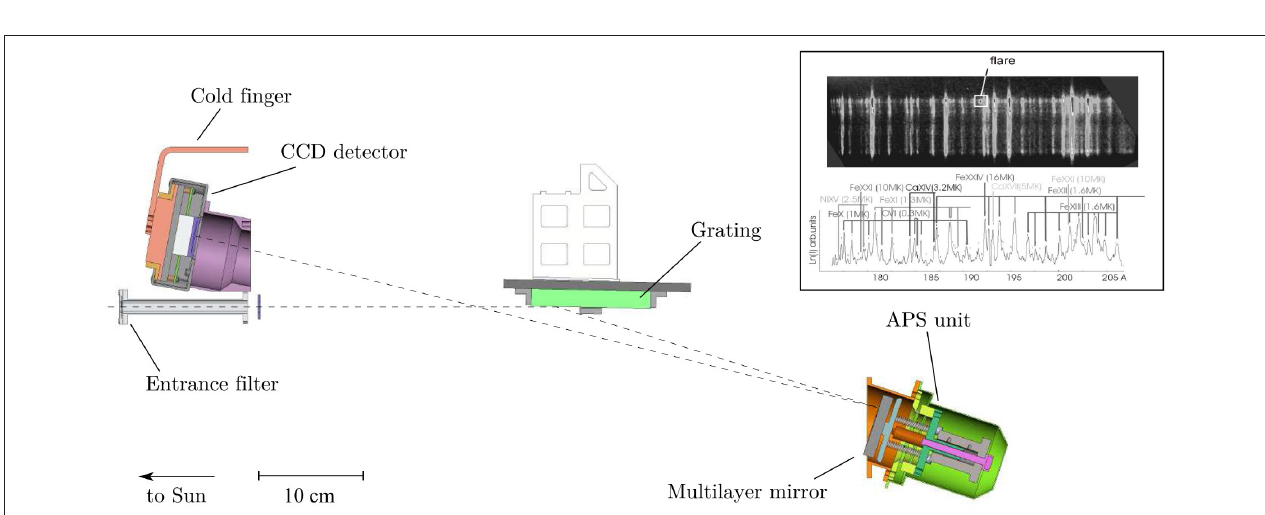
FIGURE 3 | A cross sectional view of the Grazing-Incidence Spectroheliographs (GIS) inside the KORTES-SU assembly. Top-right corner: an example of a solar spectrum (obtained with the SPIRIT instrument on 25 September, 2001). Each “cigar” on the top represent a monochromatic image of the Sun squeezed in the direction of dispersion. The corresponding spectral lines are shown at the